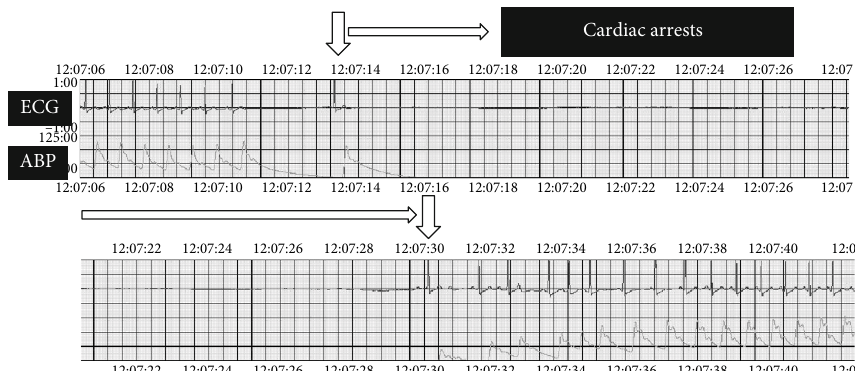
Figure 3: Electrocardiogram and arterial pressure fi ndings during the fi rst incident of cardiac arrest. ROSC resumed after approximately 15